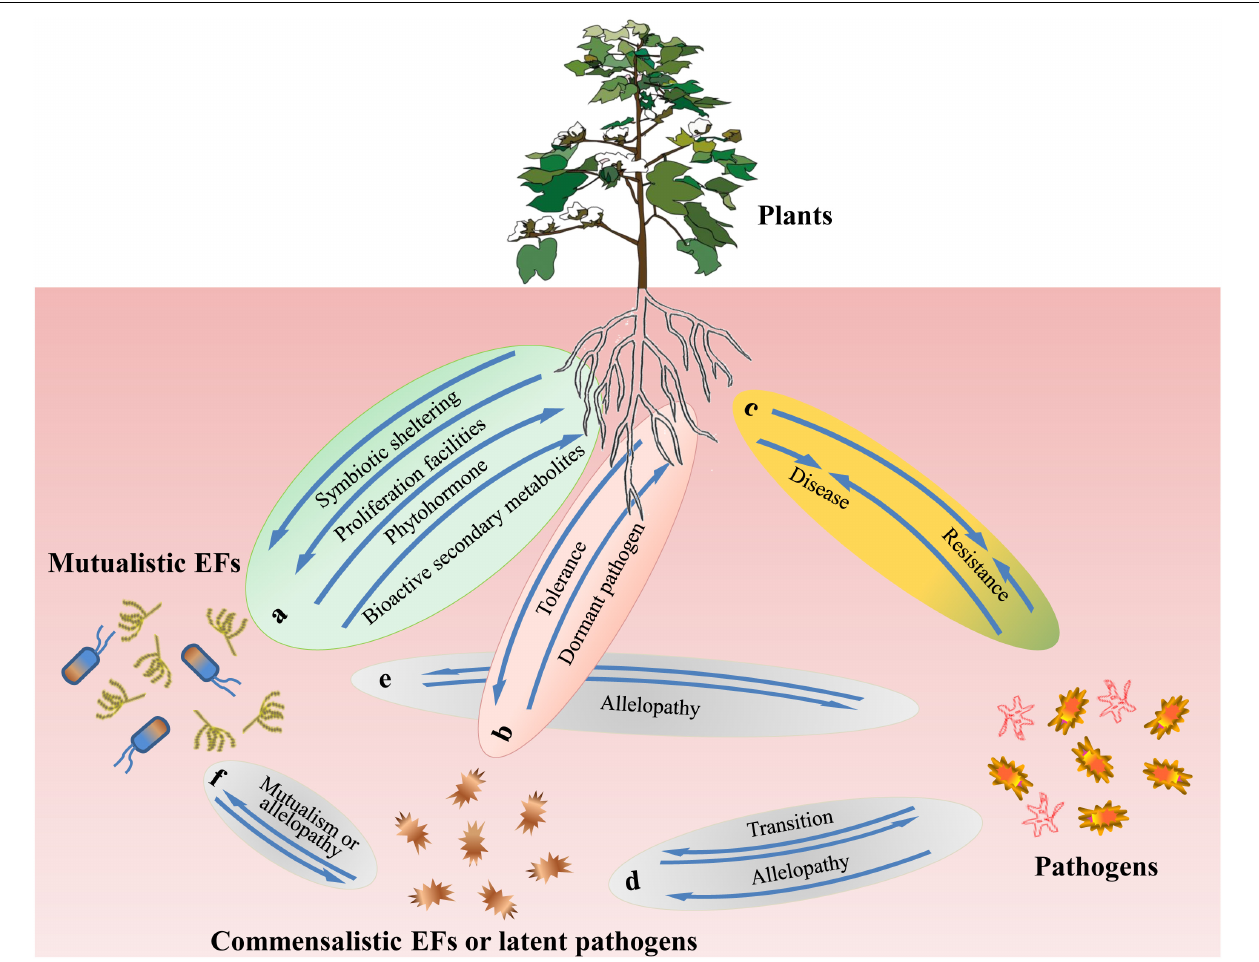
FIGURE 1 | A schematic model of plant and microbiome interactions. The interactions include: (a) interactions between plants and mutualistic endophytic fungi (EFs), (b) interactions between plants and commensalistic EFs or latent pathogens, (c) interactions between Plants and pathogens, and (d–f) interactions between